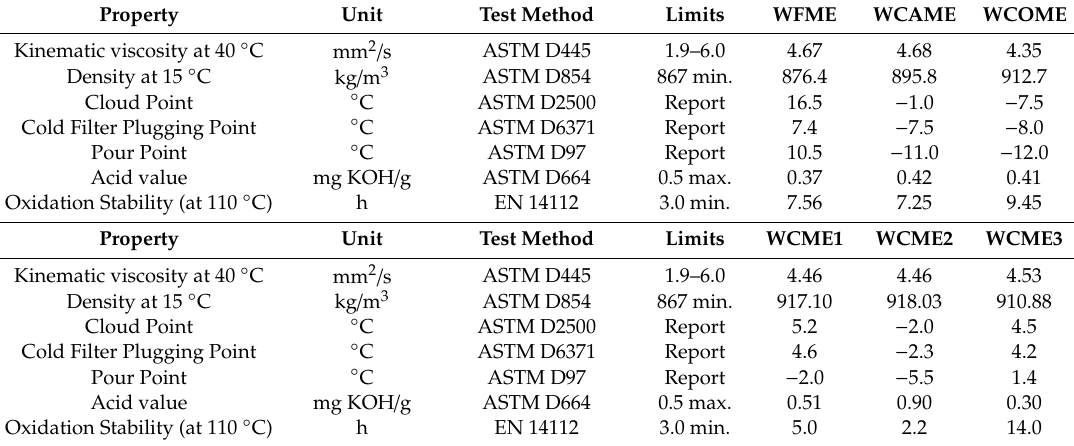
Table 2. Pure biodiesel and their mixtures according to the ASTM D6751 biodiesel standard.